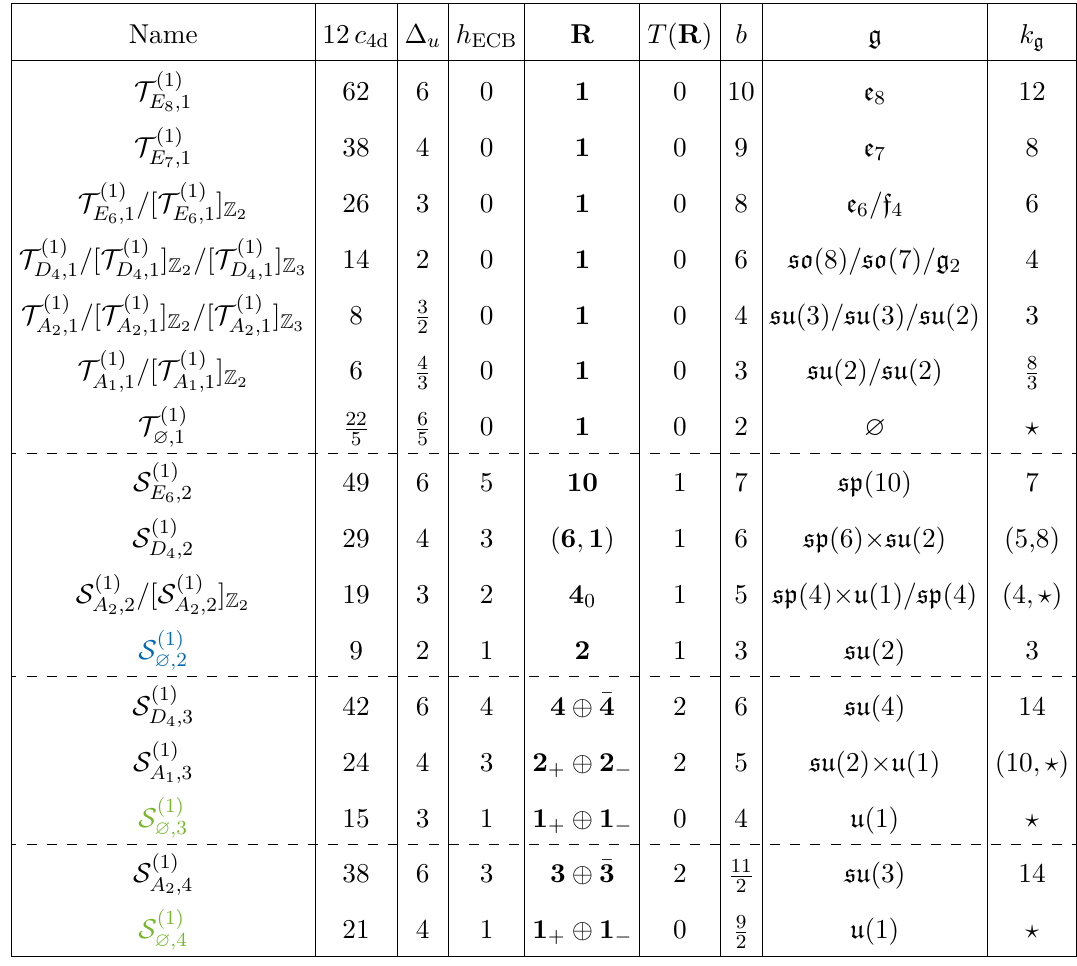
Table 1 . The list of rank-one SCFTs which can describe the low-energy physics on codimension- one singular loci of the Coulomb branch. Additional information can be found in [72]. Theories in green are N = 3 , while the theory in blue is N = 4